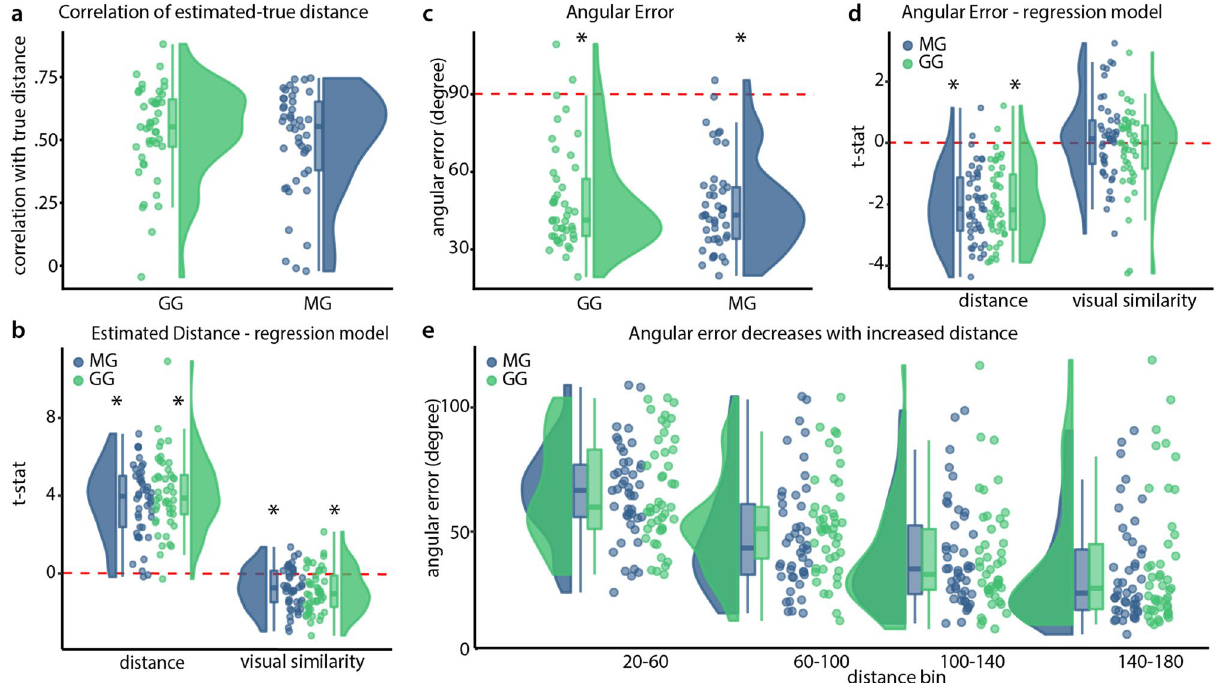
Figure 5. Distance and direction estimation task results. ( a ) Correlation of true and estimated distances. We find significant positive correlations for both groups but no difference between groups. ( b ) T-statistics from regression model for distance estimation. Regression models are fitted individually for participants, t-statistics are then compared in a permutation test. See text for an exact explanation of the procedure. Both visual similarity and distance influence distance estimation in both groups. ( c ) Absolute Angular Error. We find low errors for both groups, significantly below chance error level. ( d ) t-statistics from regression model for angular error for distance and visual similarity. Angular errors are smaller with increased distance, but show no linear relation to visual similarity. ( e ) Illustration of relationship between angular error and distance between positions. The goal and start location had four different distances as indicated by the distance bins on the x-axis. Performance in the angle estimation increased with increased distances. Green indicates participants from the gamepad group, blue from the movement group. We use raincloud plots to visualize individual data points, box plots with marks for median as well as 25th and 75th percentile percentiles and a half-violin plot for a density distribution. Red dotted lines indicate chance level. See text for exact